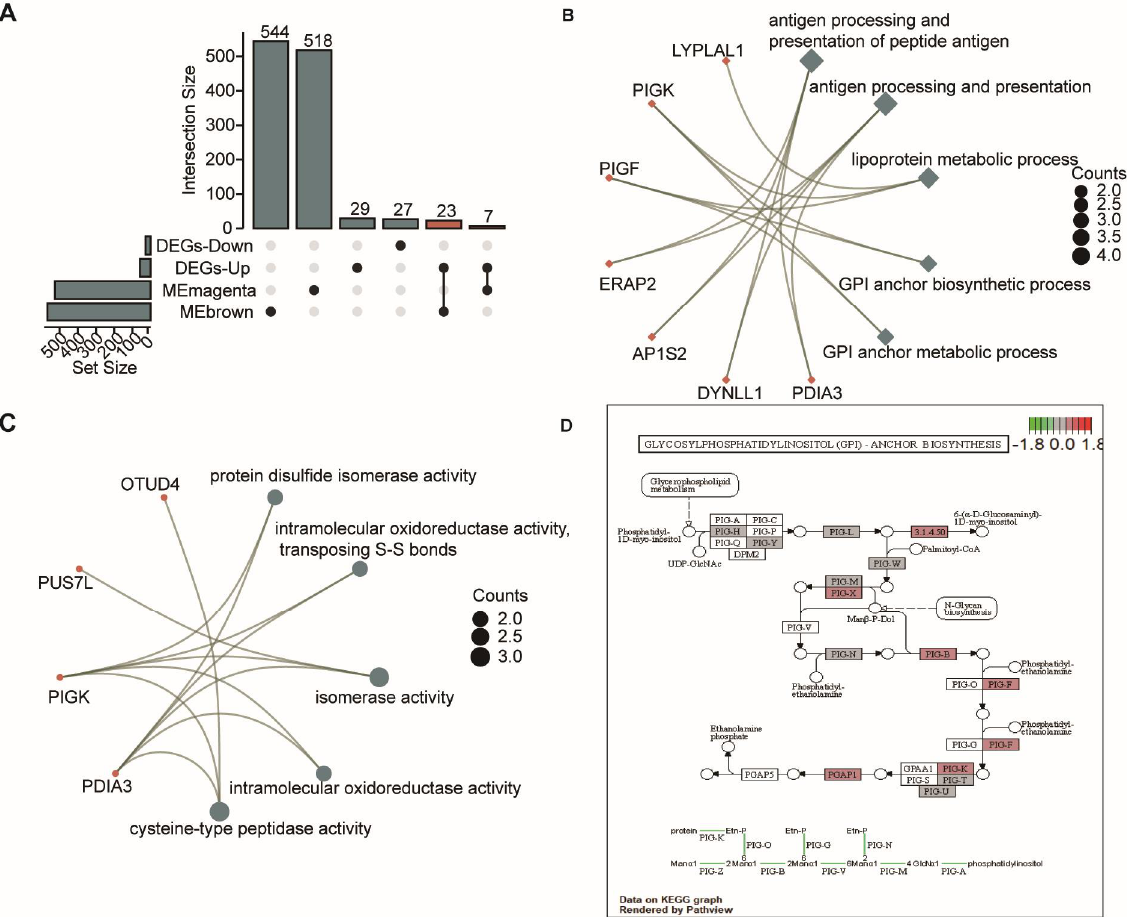
Figure 4. Identification of OSA-specific genes and enrichment analysis. ( A )The Venn diagram of the genes in co-expression modules and DEmRNAs. ( B ) Significant enriched GO biological process terms. ( C ) Significant enriched GO molecular function terms. ( D ) KEGG pathway analysis and visualization of both gene expression and metabolomics data. Gene expression levels are indicated as significantly higher (red), unchanged (gray), or lower (green). The differences of hsa00563 glycosylphosphatidylinositol (GPI)-anchor biosynthesis pathways between OSA patients and normal controls.